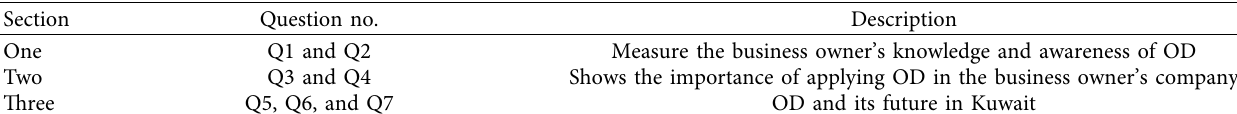
Table 1: Survey questions divisions.